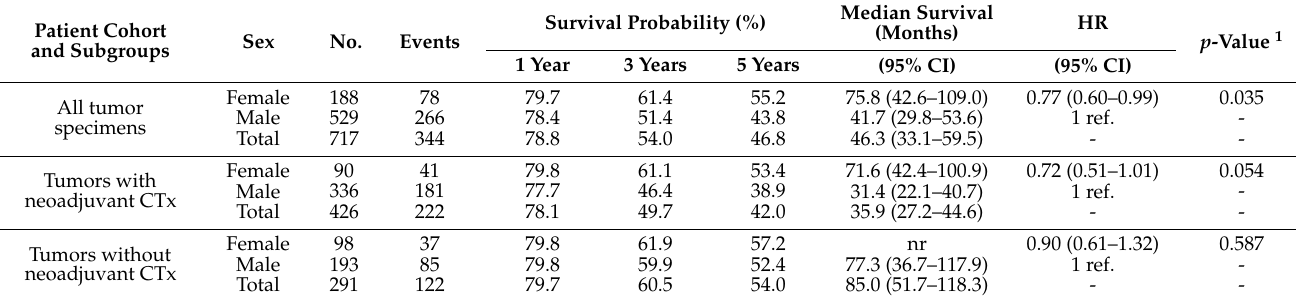
Figure 2. Discrimination of patients’ survival by sex. Kaplan–Meier curves of female or male patients are shown. All GC patients ( a ), patients treated with neoadjuvant CTx ( b ) and patients treated with surgery alone ( c ). * p = 0.035, ** p = 0.054, Cox-regression. Table 2. Survival data of the patient cohort and subgroups in association with